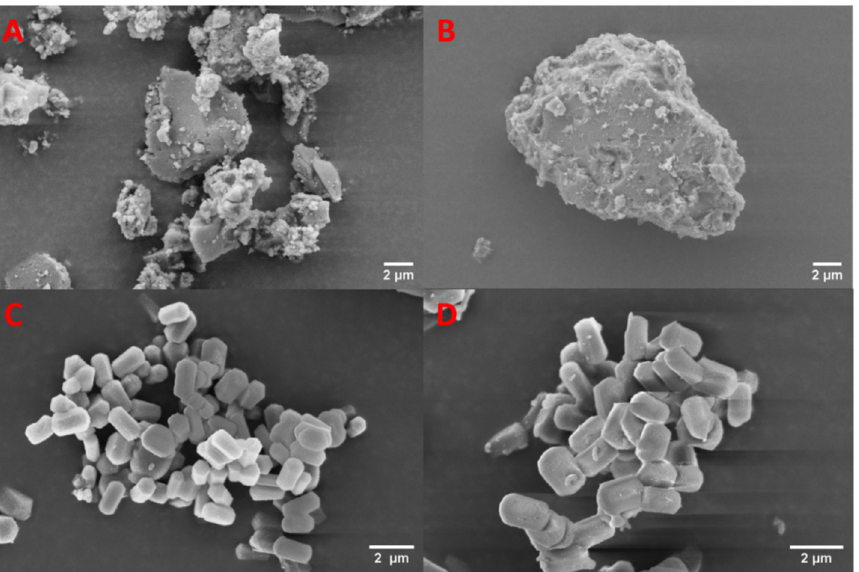
Figure 7. SEM images of ( A ) unloaded MMC; ( B ) drug-loaded MMC; ( C ) unloaded MCM-41; and ( D ) drug-loaded MCM-41.